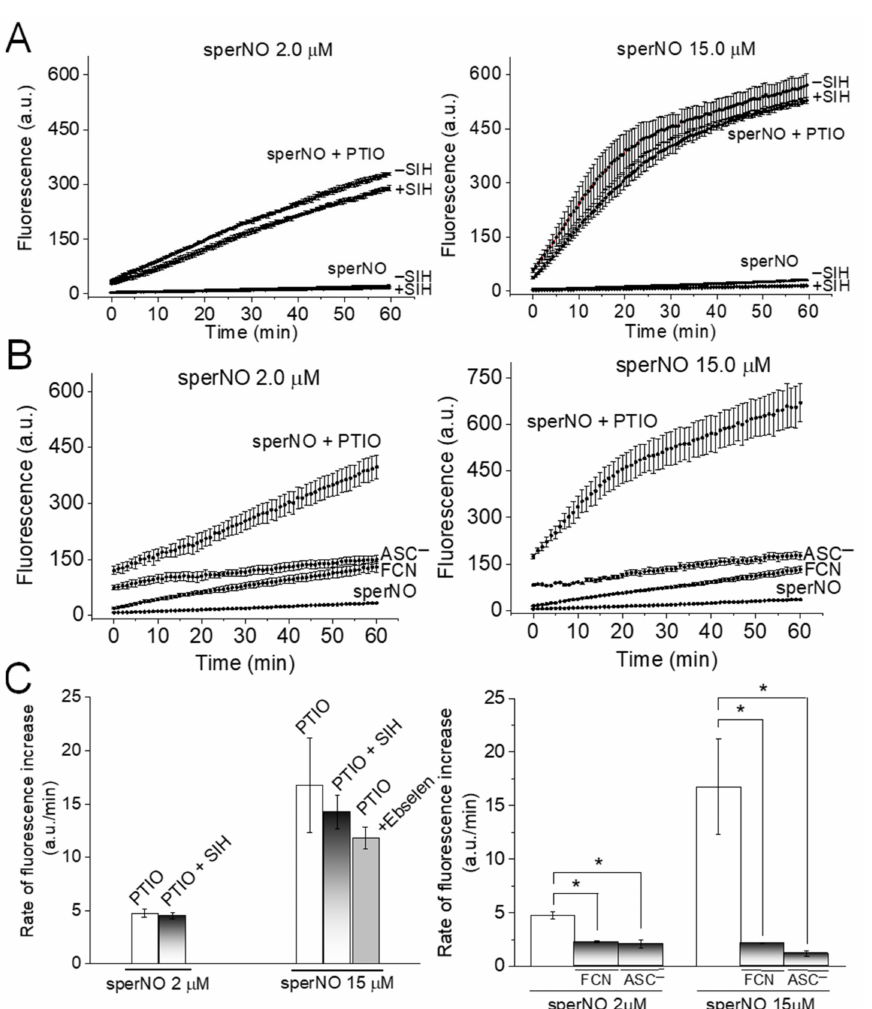
Figure 3. NO • -dependent intracellular oxidation of H 2 DCF and the effects of SIH and Ebselen. A 2 suspension of H 2 DCF-loaded RAW 264.7 cells was transferred to 96-well plates (1.2 × 10 7 cells/mL) and treated with sperNO (2 or 15 µ M) in the presence of PTIO (250 µ M) plus or minus SIH (100 µ M). ( A ) . Fluorescence traces of the oxidation of H 2 DCF by NO • generated by combination of sperNO 2 and PTIO; ( B ) . Fluorescence traces of the oxidation of H 2 DCF by NO • generated by combination 2 of sperNO and PTIO in the presence of the NO • scavenger potassium hexacyanoferrate (II) [55] or 2 ascorbate (100 µ M). The data in panels A and B represent the mean ± S.D of three experiments and are statistically significant at the 95% confidence interval relative to control cells * ( p < 0.05, Paired Student’s t -test); ( C ) . Rate of the NO • -dependent intracellular oxidation of H 2 DCF shown in ( A ) and 2 ( B ). The data represent the mean of three independent experiments ± S.D. The assays were performed in PBS and DTPA (100 µ M), at pH 7.4, and 37 ◦ C, and the fluorescence acquisition parameters were λ ex = 498 nm, λ em = 523 nm, and ex and em slit width = 9 and 15 nm,